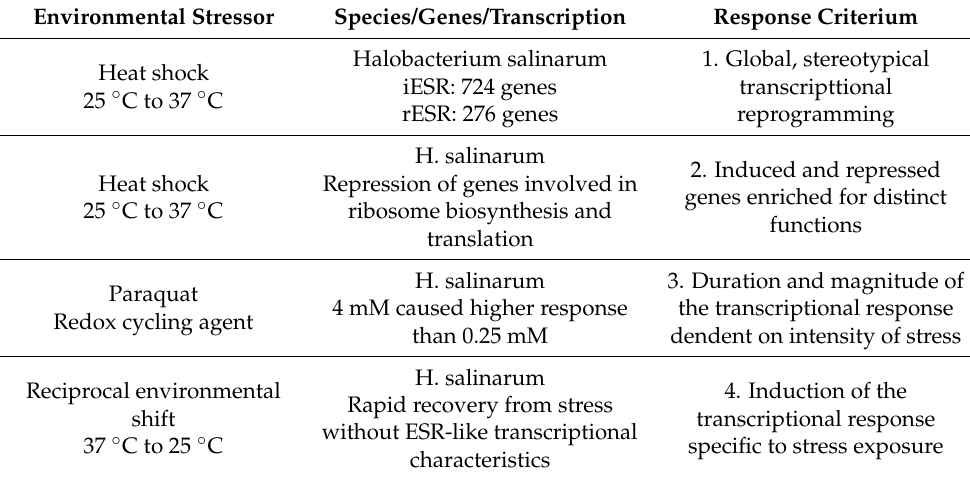
Table 7. Archaic environmental stress